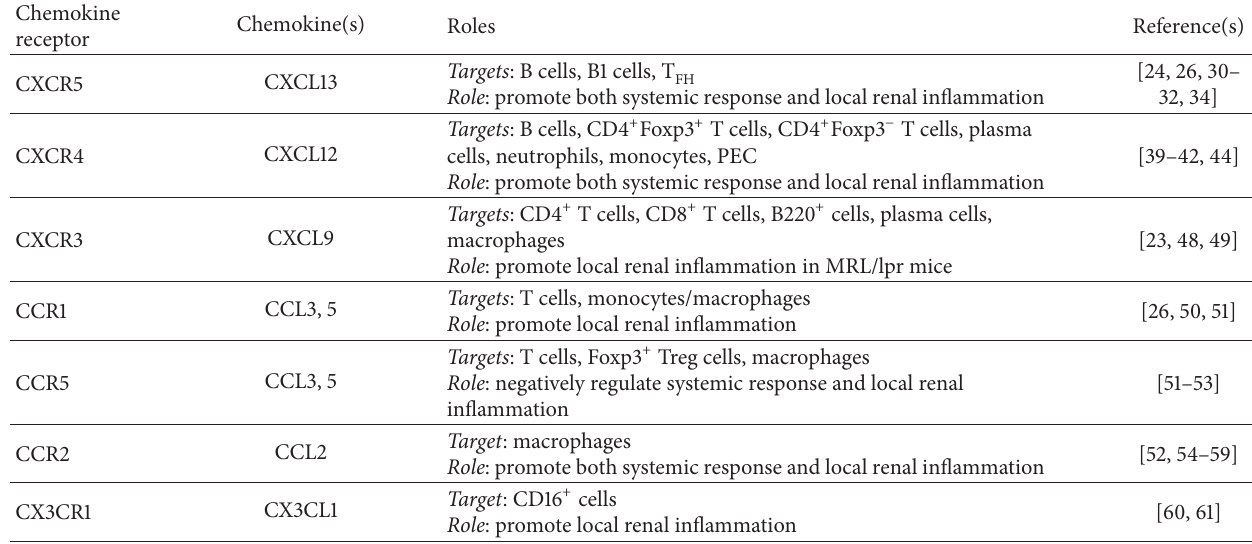
Table 1: Target cells and roles of chemokine receptors and chemokines in lupus-prone mouse models of LN.